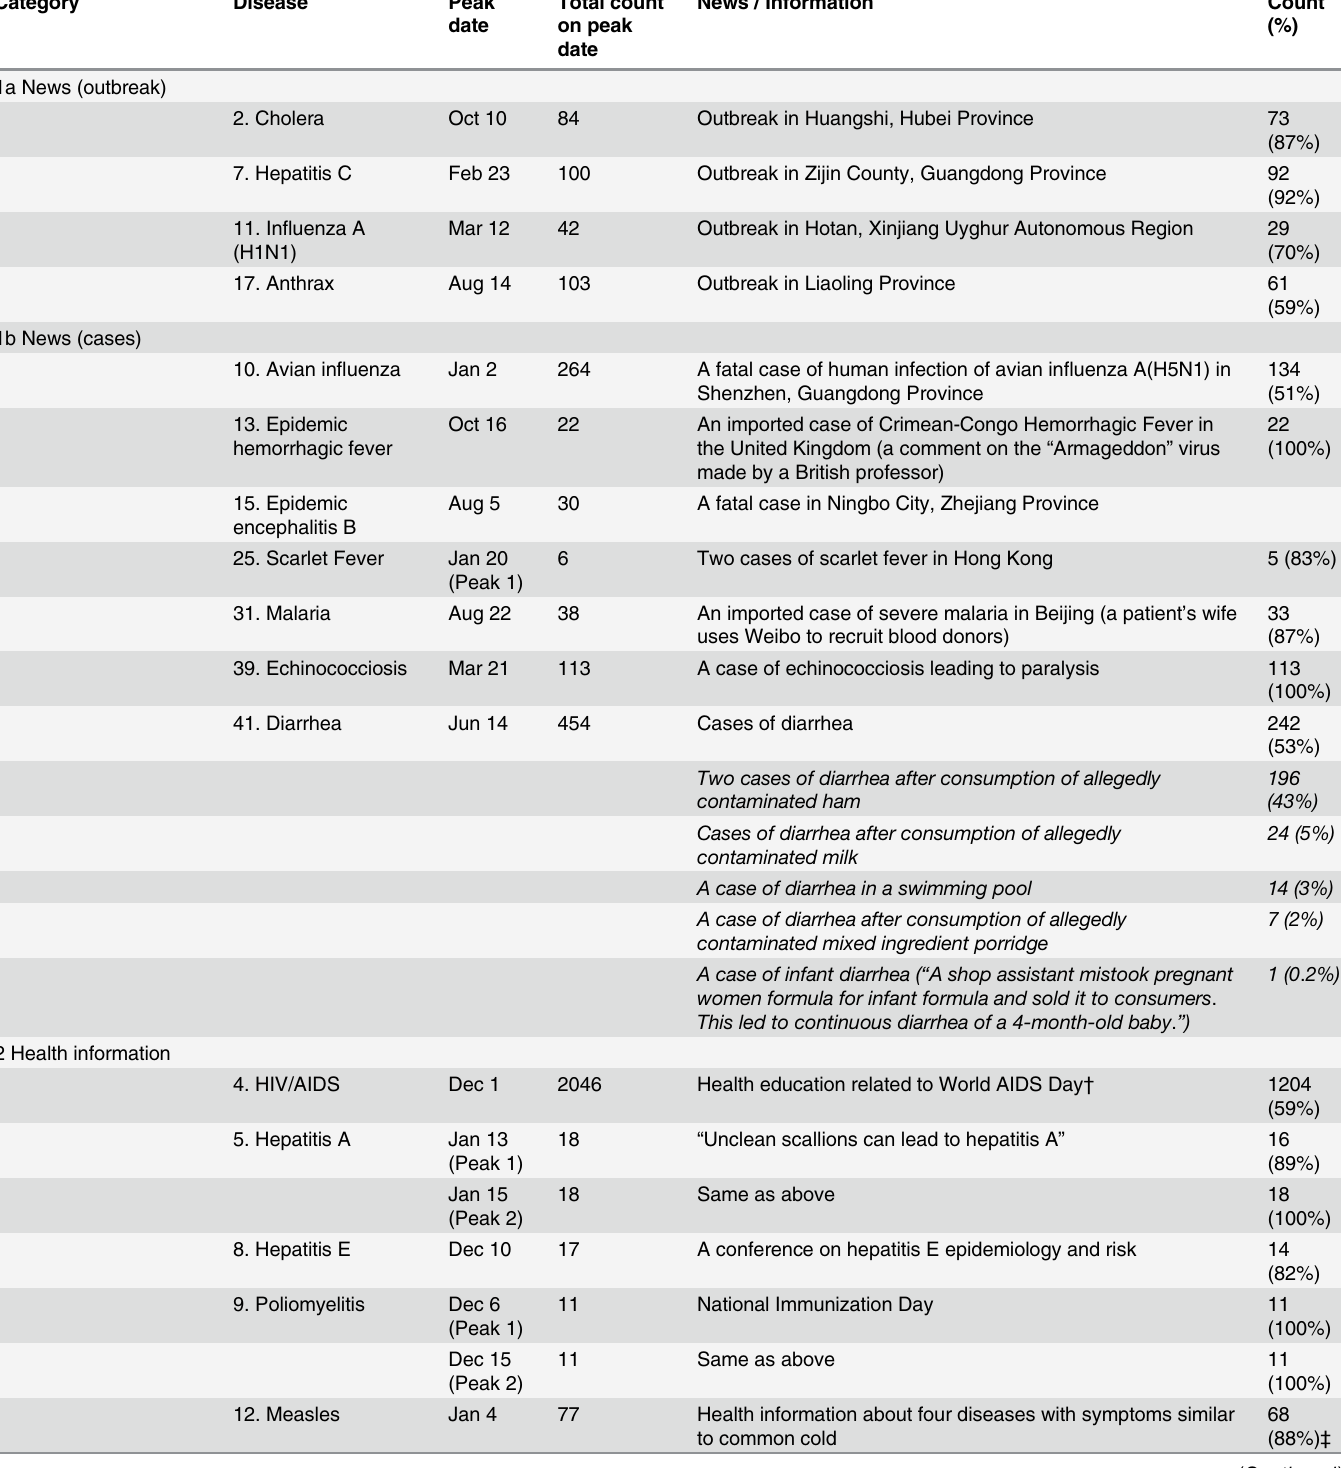
Table 2. News and information that led to a peak in Weibo traffic as found in the WeiboScope database, January 1 to December 31, 2012. *